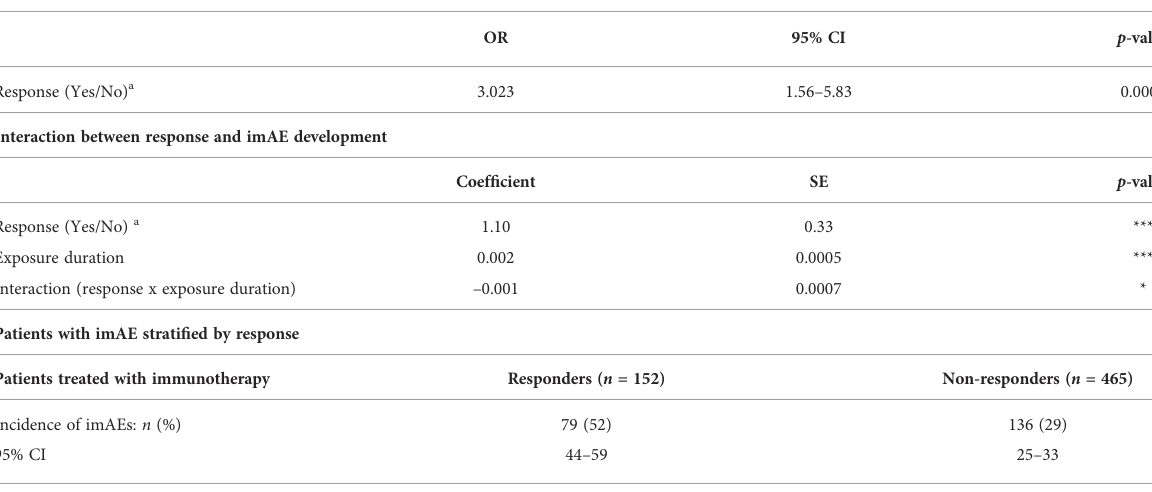
TABLE 2 Relationship between imAE development and objective